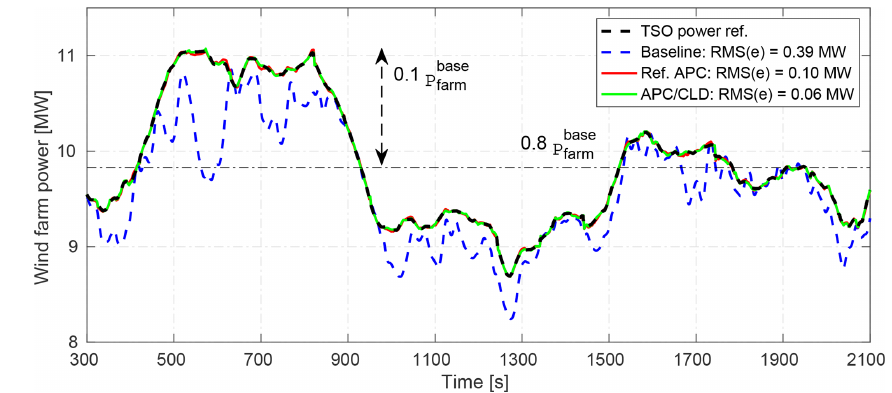
Figure 12. Total power production of the wind farm with closed-loop APC with coordinated load distribution (CLD). The time-varying power reference parameters Eq. (23) are chosen here as P base wind farm power with locally greedy induction factors a i = 1 / 3 (see Fig. 4).